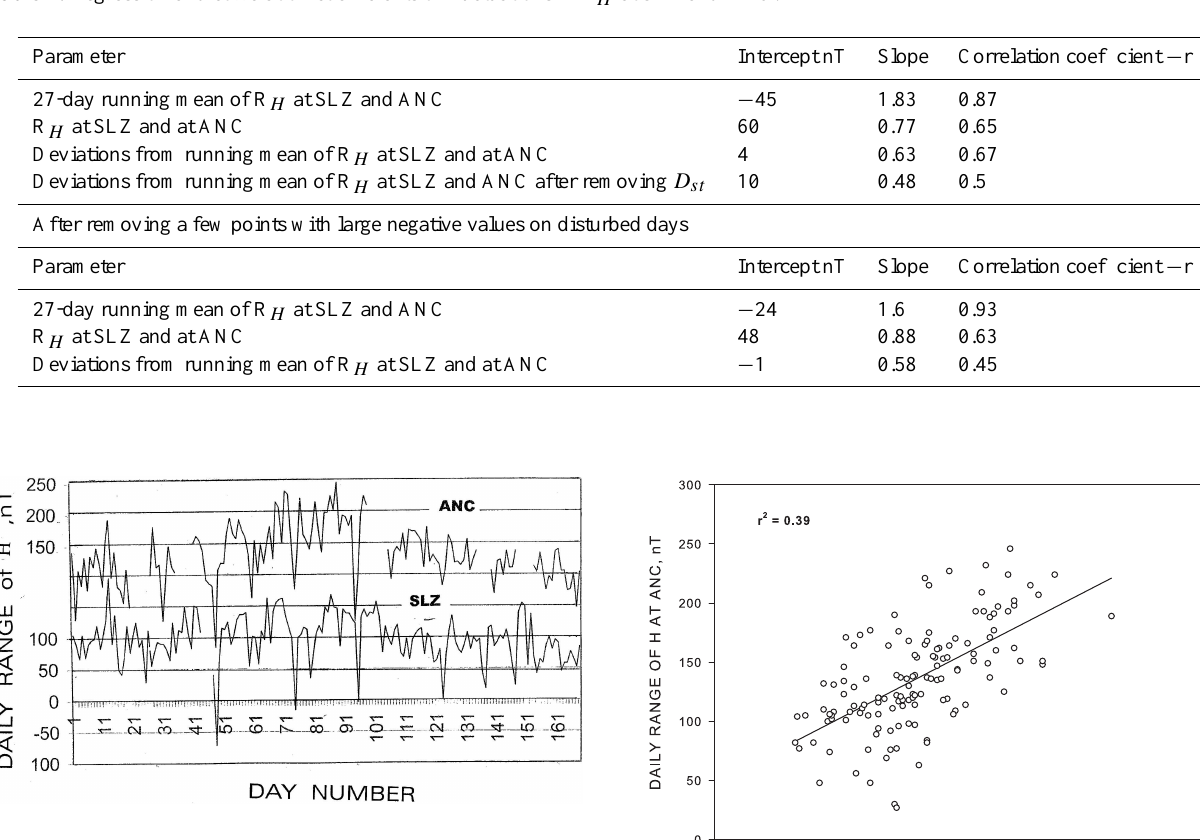
Fig. 2a. Day-to-day variations of the daily ranges of H at ANC and SLZ for the period January to June 1993.